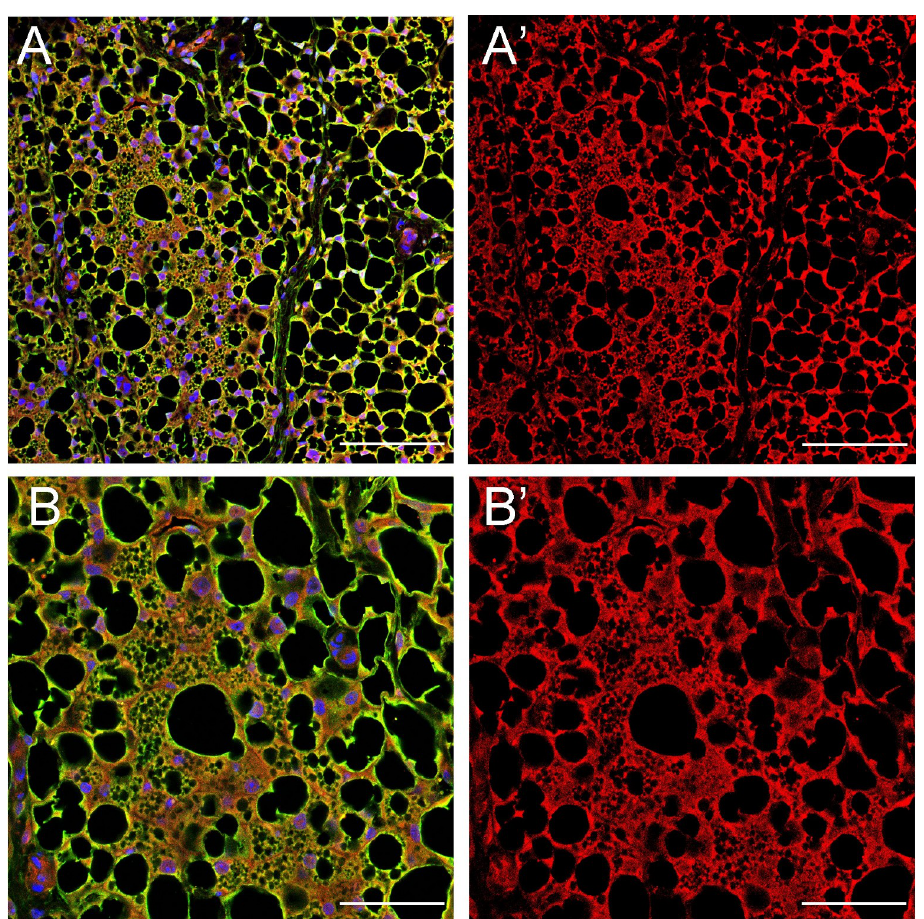
Fig 4. Meflin lineage cells become beige like adipocytes. Meflin- CreER T2 /Rosa26-tdTomato mice were subjected to cold stimulation at 6˚C for 48 h. Inguinal WAT (iWAT) was then harvested. (A, A’) Immunostaining image shows tdTomato (red)- and UCP1 (green)-positive cell masses. (B, B’) Magnified images of A and A’. The cells in the center have the morphological characteristics of beige adipocytes. Scale bars represent 100 μ m in (A) and (A’) and 50 μ m in (B) and (B’). A, B: Merged (UCP1 + tdTomato + DAPI), A’, B’: